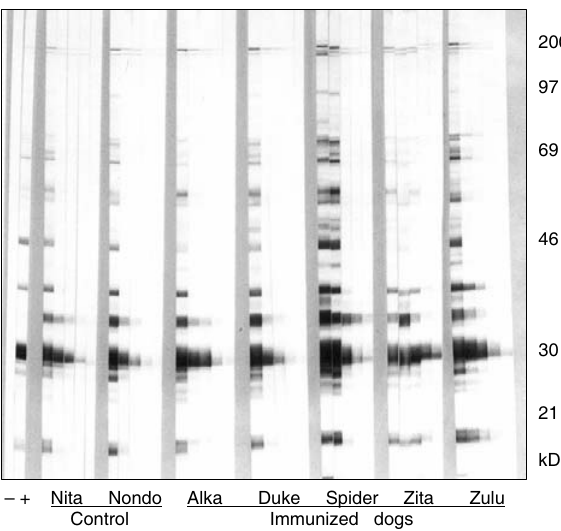
FIG. 1A Western blots to evaluate E. canis specific antibody levels in the sera of the two control dogs, Nita (NI) and Nondo (NO), and the five immunized dogs, Alka, Duke, Spider, Zita, Zulu, 2 weeks post third immunization.